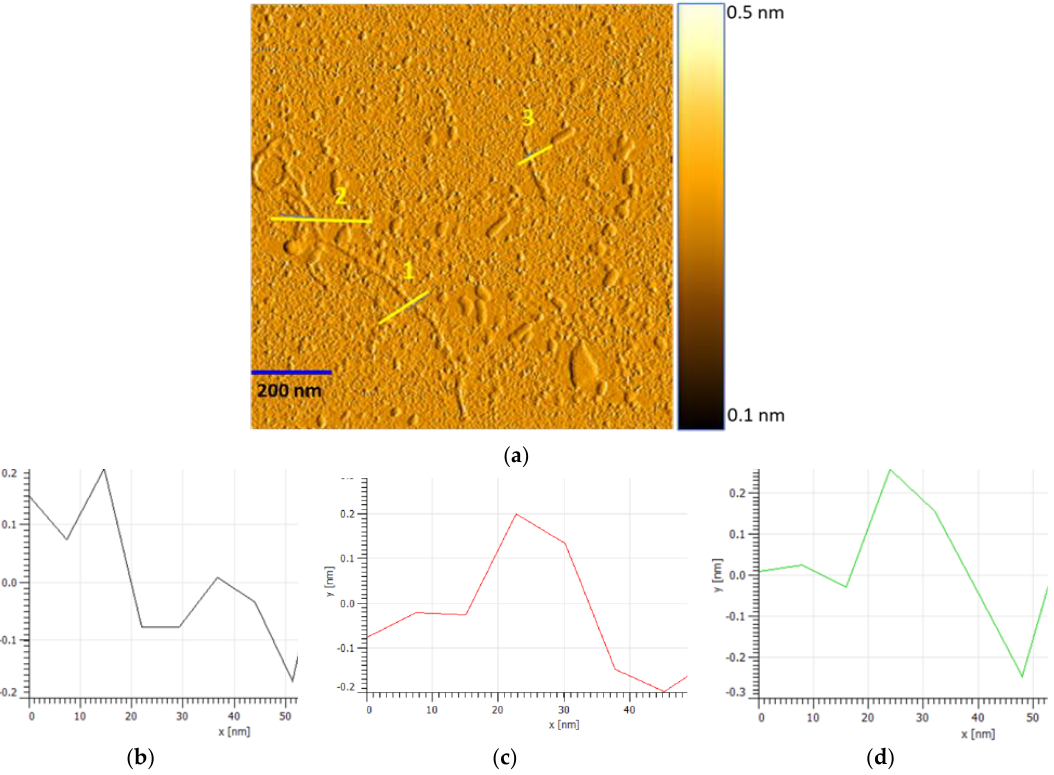
Figure 7. ( a ): AFM image of the CoMoCAT SG 65 SWCNTs with a diameter between 0.7 nm–0.9 nm. 1, 2 and 3 are the measured line profiles; ( b – d ): measured AFM line profiles with average tube diameter ~0.5 nm for profiles 1, 2 and 3,